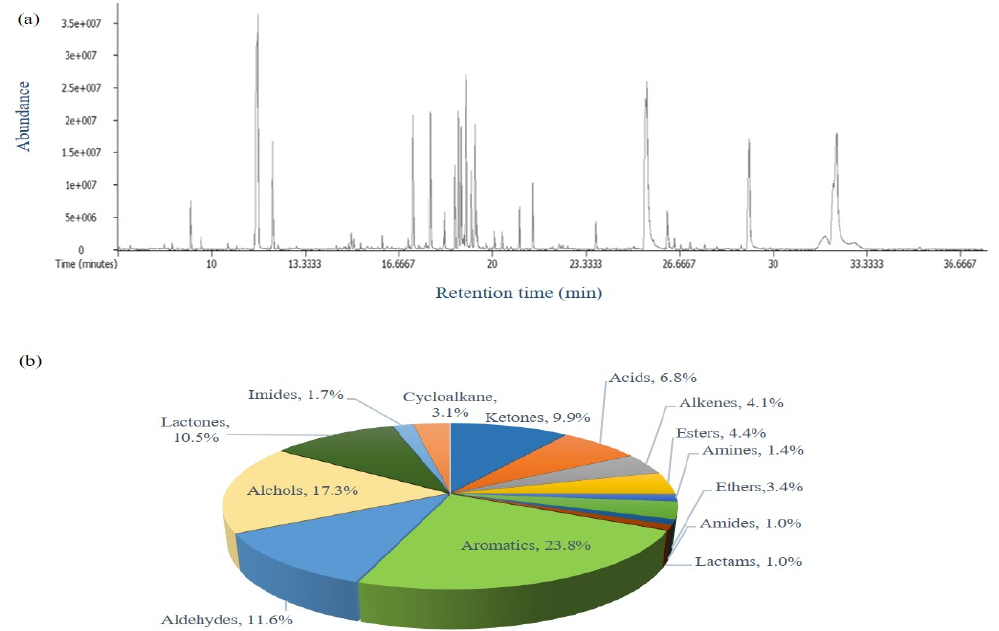
Figure 1. ( a ) Typical total ion chromatogram and ( b ) relative contents (%) of chemical classes of Xanthii Fructus samples obtained by headspace solid-phase microextraction/gas chromatography- time-of-flight mass spectrometry (HS-SPME/GC-TOF MS).